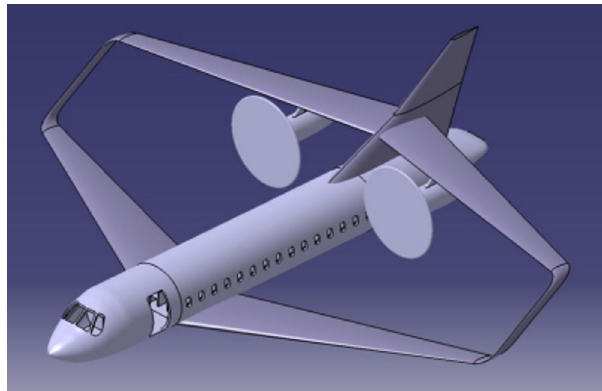
Fig. 8. An example of Prandtl Plane regional aircraft.